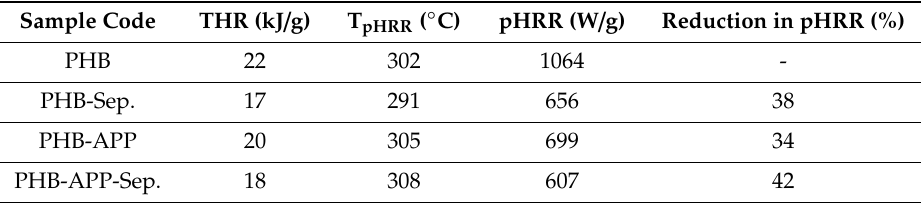
Table 9. Summary results of Pyrolysis Combustion Flow Calorimeter (PCFC) tests.